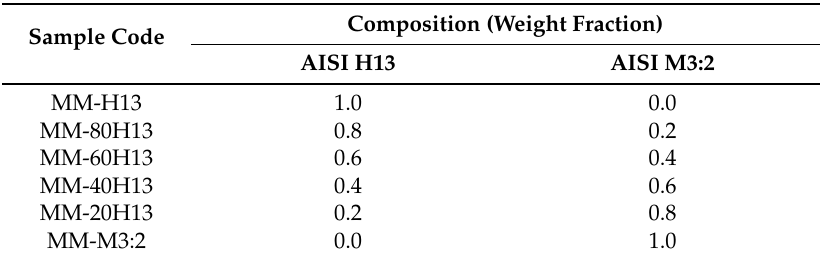
Table 2. Composition and coding of the